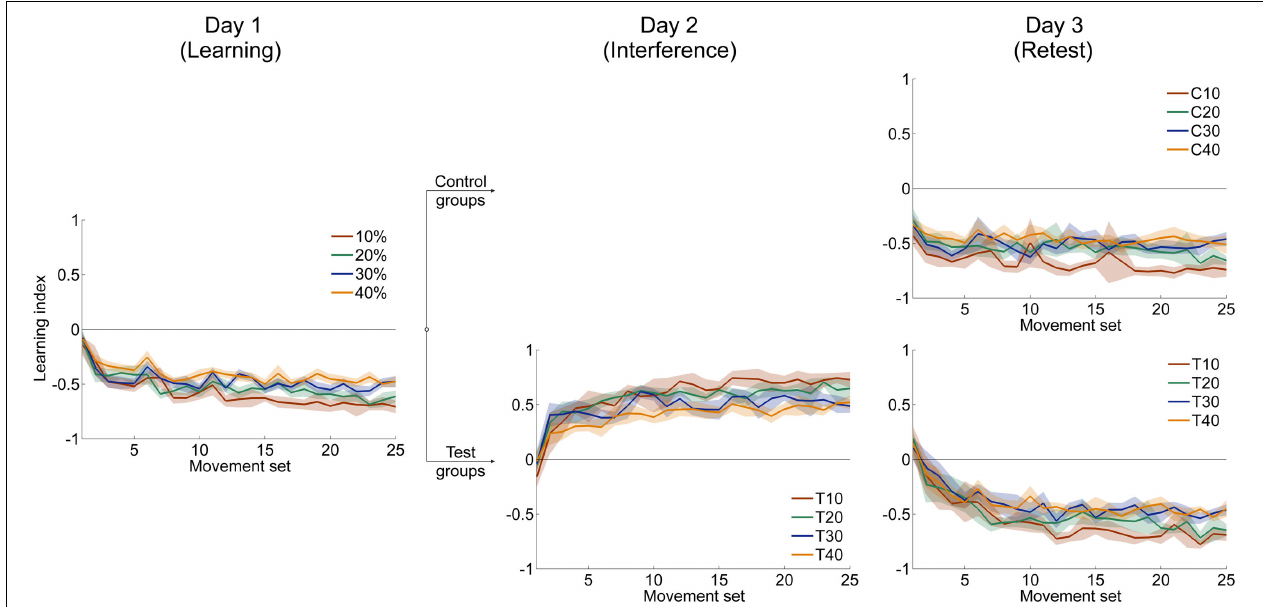
FIGURE 6 | Mean time courses of learning index which relates catch trials and force field trials. Learning of the clockwise-directed force field A is indicated with negative values, learning of the counterclockwise-directed force field B has positive sign. All data is presented as mean values ± 95% confidence intervals.